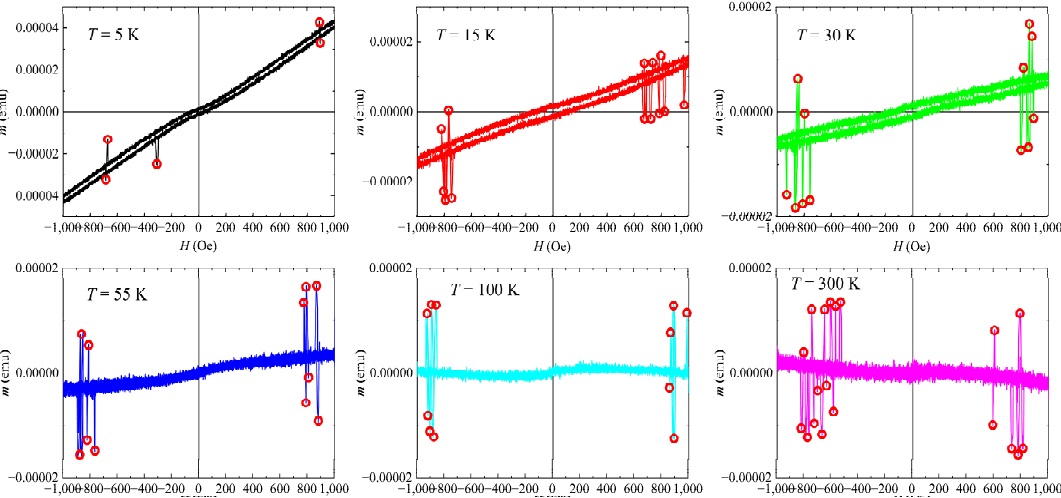
Figure 4. m ( H ) curves in the range − 1000 Oe < H < +1000 Oe. Several spike-like magnetization jumps (indicated by open red circles) can be observed at different fields for all the reported temperatures.